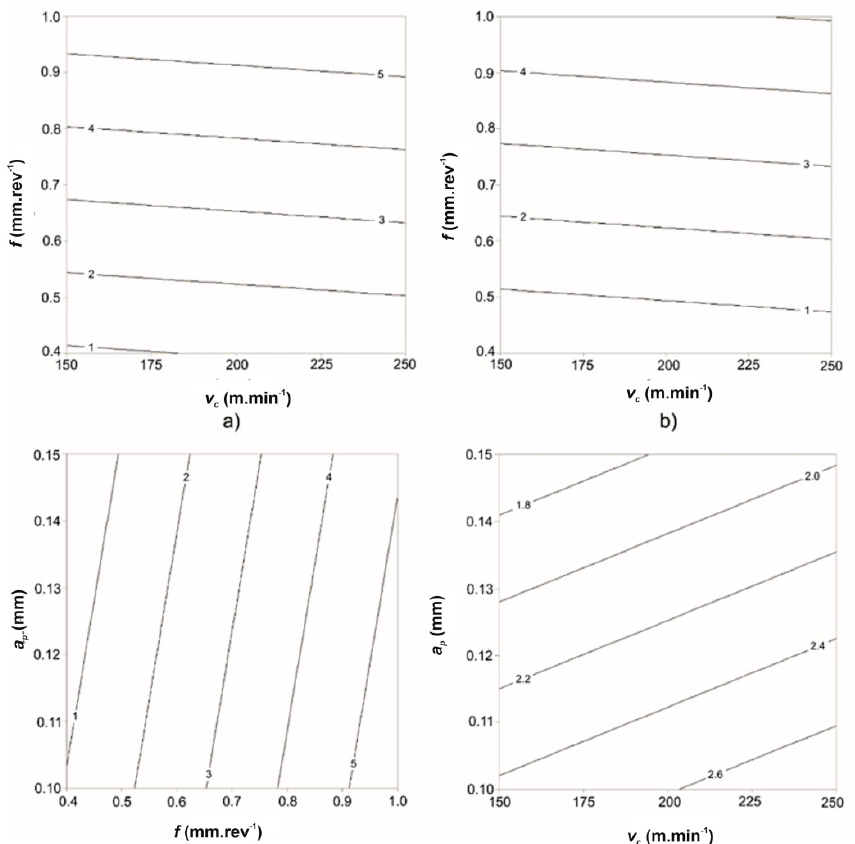
Figure 6. Dependence of change of the value Ra on the change of cutting conditions: ( a ) a p = 0.1 mm, ( b ) a p = 0.15 mm, ( c ) v c = 200 m·min − 1 , ( d ) f = 0.6 mm·rev − 1 .